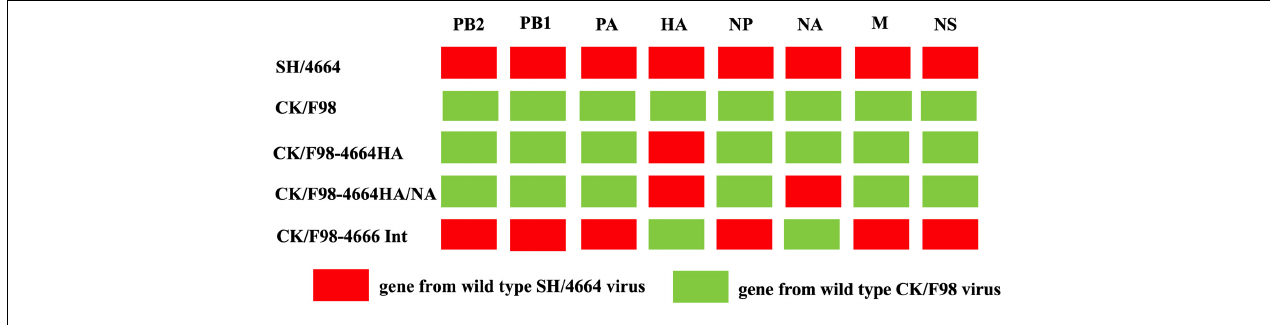
FIGURE 1 | Schematic of H7N9-H9N2 hybrid viruses analyzed in this study.